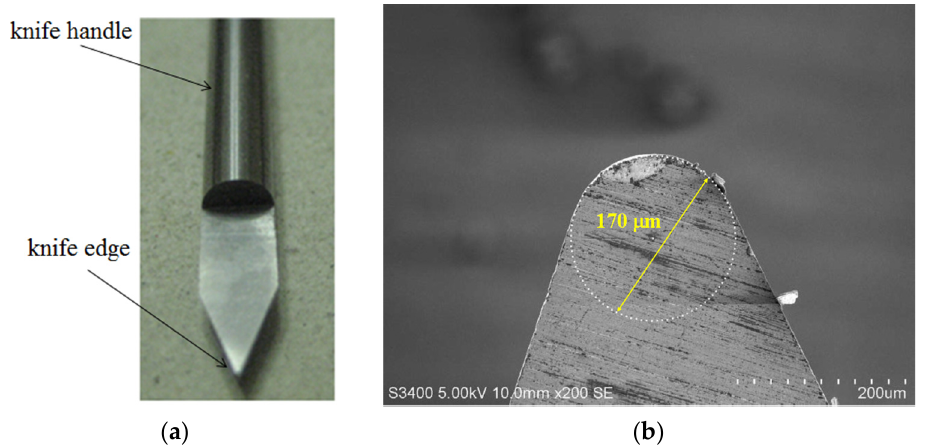
Figure 1. The microshaper mounted on the CNC machine has a small nose radius on the knife edge. (a) Photo of the microshaper. (b) SEM of the knife tip of microshaper. The tip of knife has diameter of 170 μ m (radius of 85 μ m).